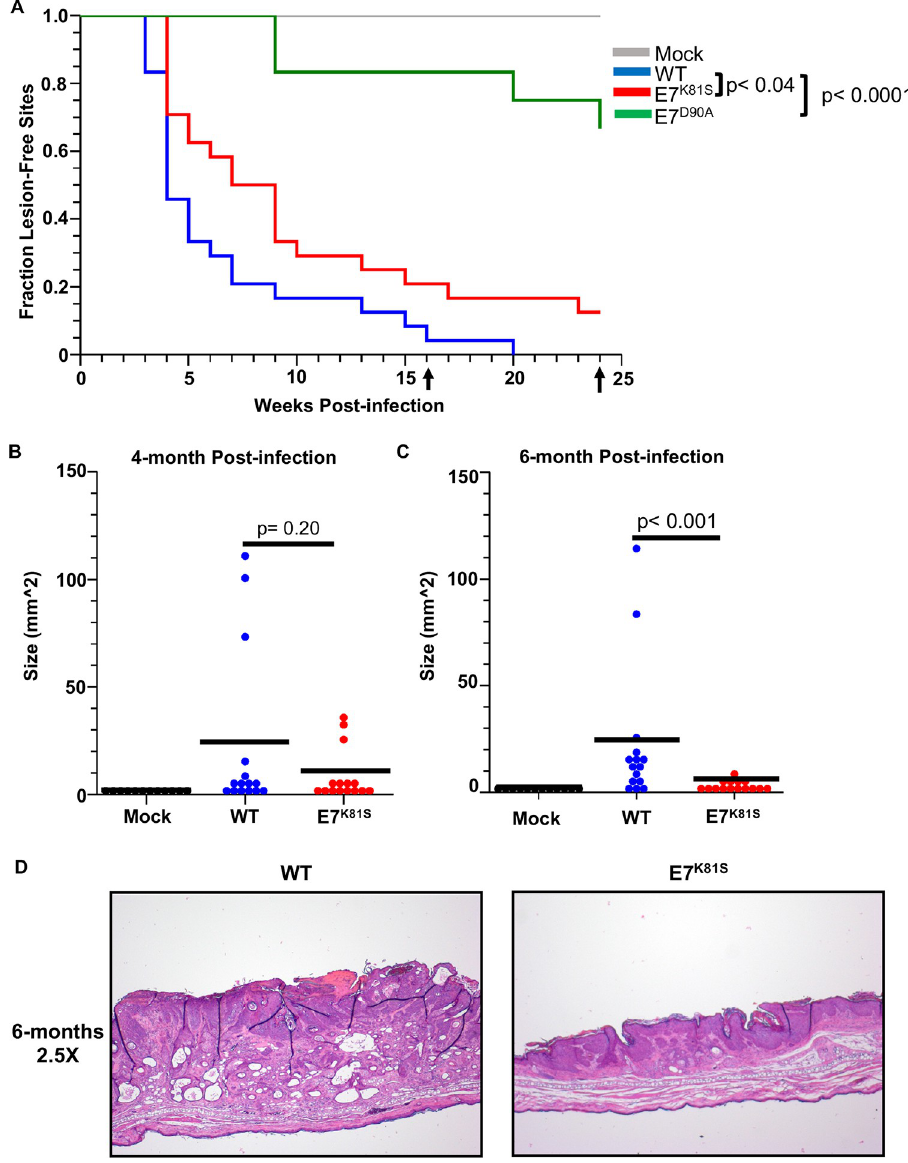
Fig 4. E7 K81S MmuPV1 induces lesions at a slower rate and the lesions are smaller in size than those induced by WT MmuPV1. (A) Mice were monitored for papilloma development over a 6-month period every two weeks following infection. Each ear was considered a site of infection and the week post-infection that a lesion developed was recorded. A Kaplan-Meier curve was generated using the week post-infection versus fraction of lesion-free sites across all animals. Data was subjected to Log-Rank test to assess statistical significance (p < 0.05 was considered significant). (B&C) Lesions were measured at the time of collection for area of lesion size (depth was excluded from measurements). Data was plotted as dot plots with each site measured represented by a single dot. Wilcoxon-rank sum analysis was performed on the data to assess statistical significance (p < 0.05 was considered significant). Black bars indicate the mean for each condition. (D) Images of H&E-stained tissue sections at 2.5X magnification to show size differences of lesions at 6-months